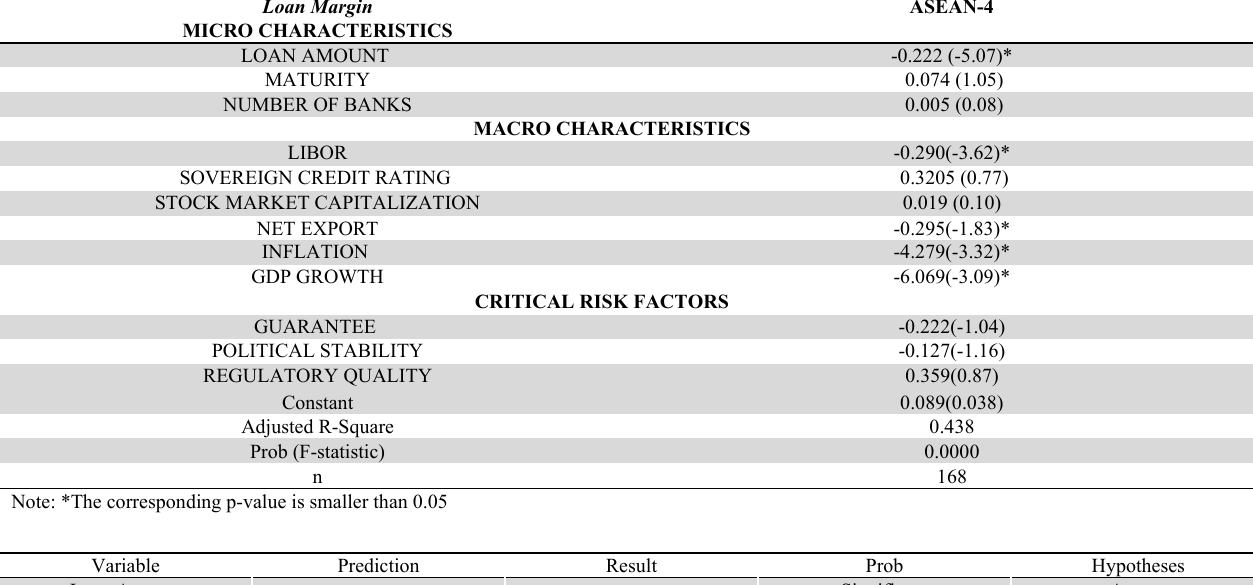
OLS Regression Results and the